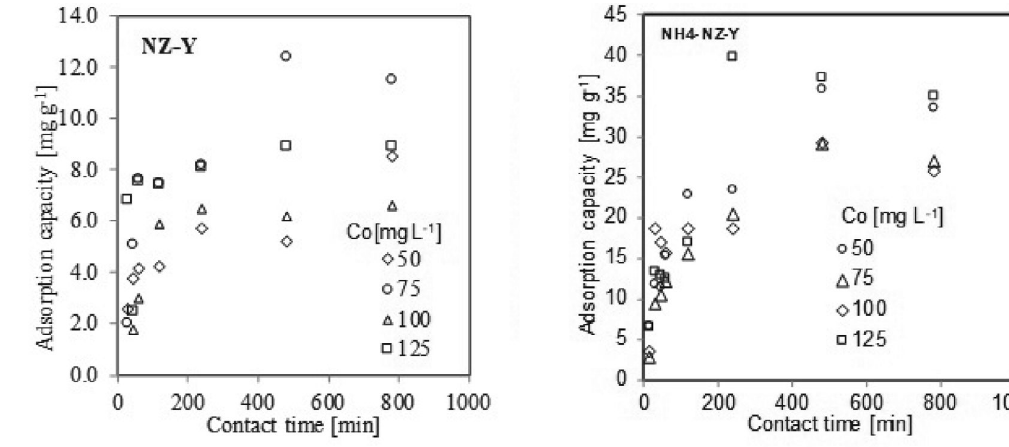
Figure 4. Adsorption capacity of NZ-Y and NH4-NZ-Y for removal of As(III) as a function of contact time.